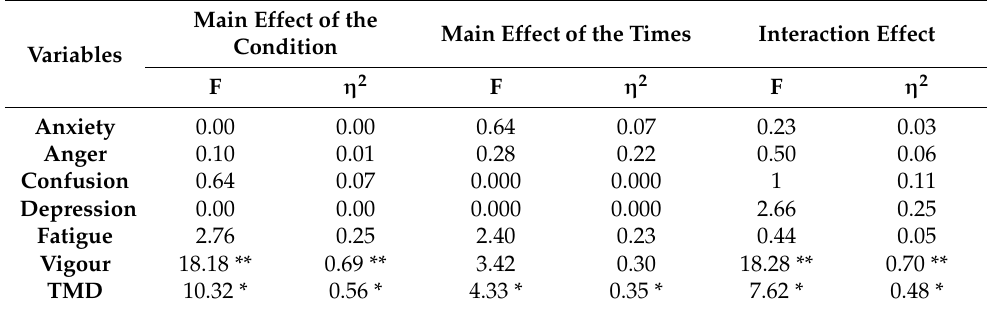
Table 4. POMS scores measured before and after high intensity interval training (HIIT) or small-sided games (SSG).